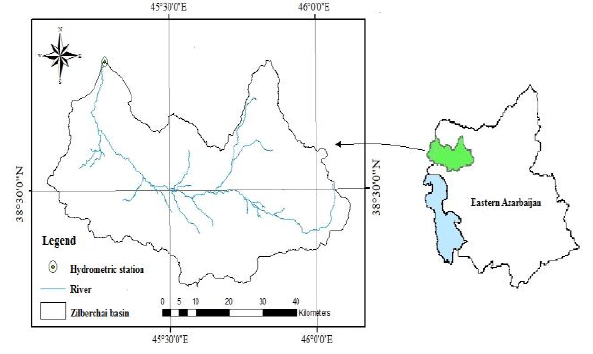
Figure 1. The location of the study area